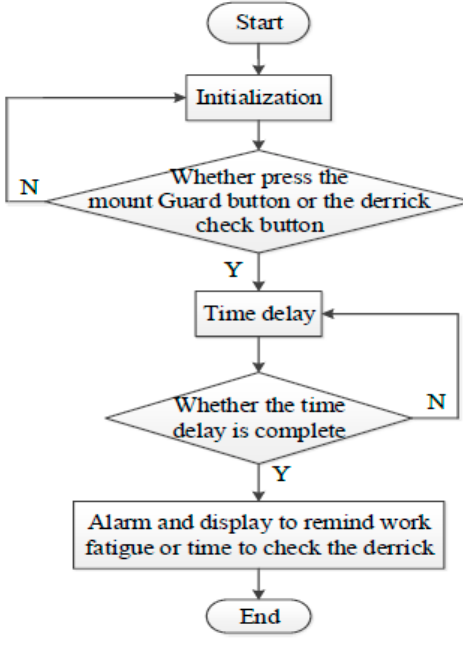
Figure 12. Program flow chart of remind alarm.